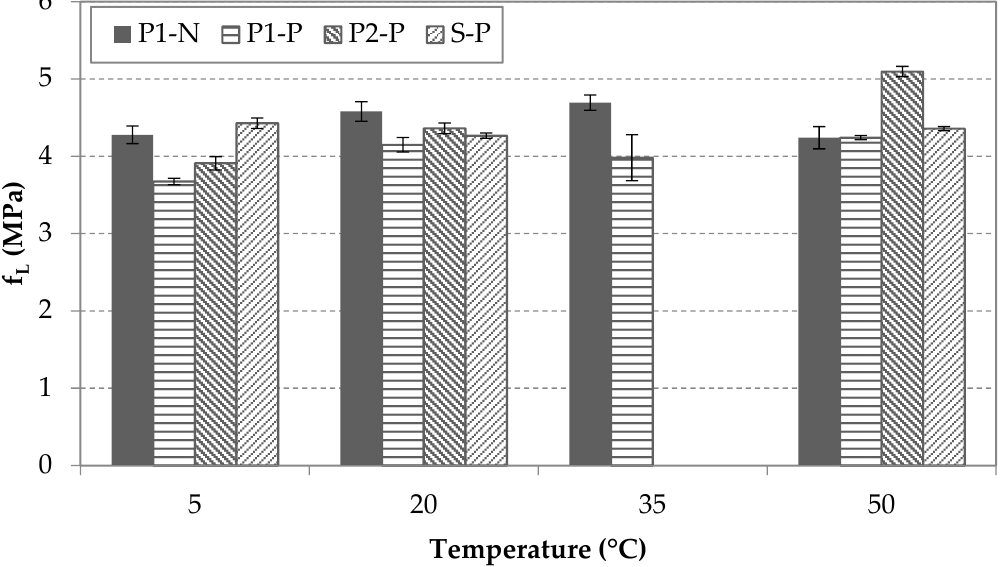
Figure 8. Results of f L for each type of fiber and condition at different temperatures.